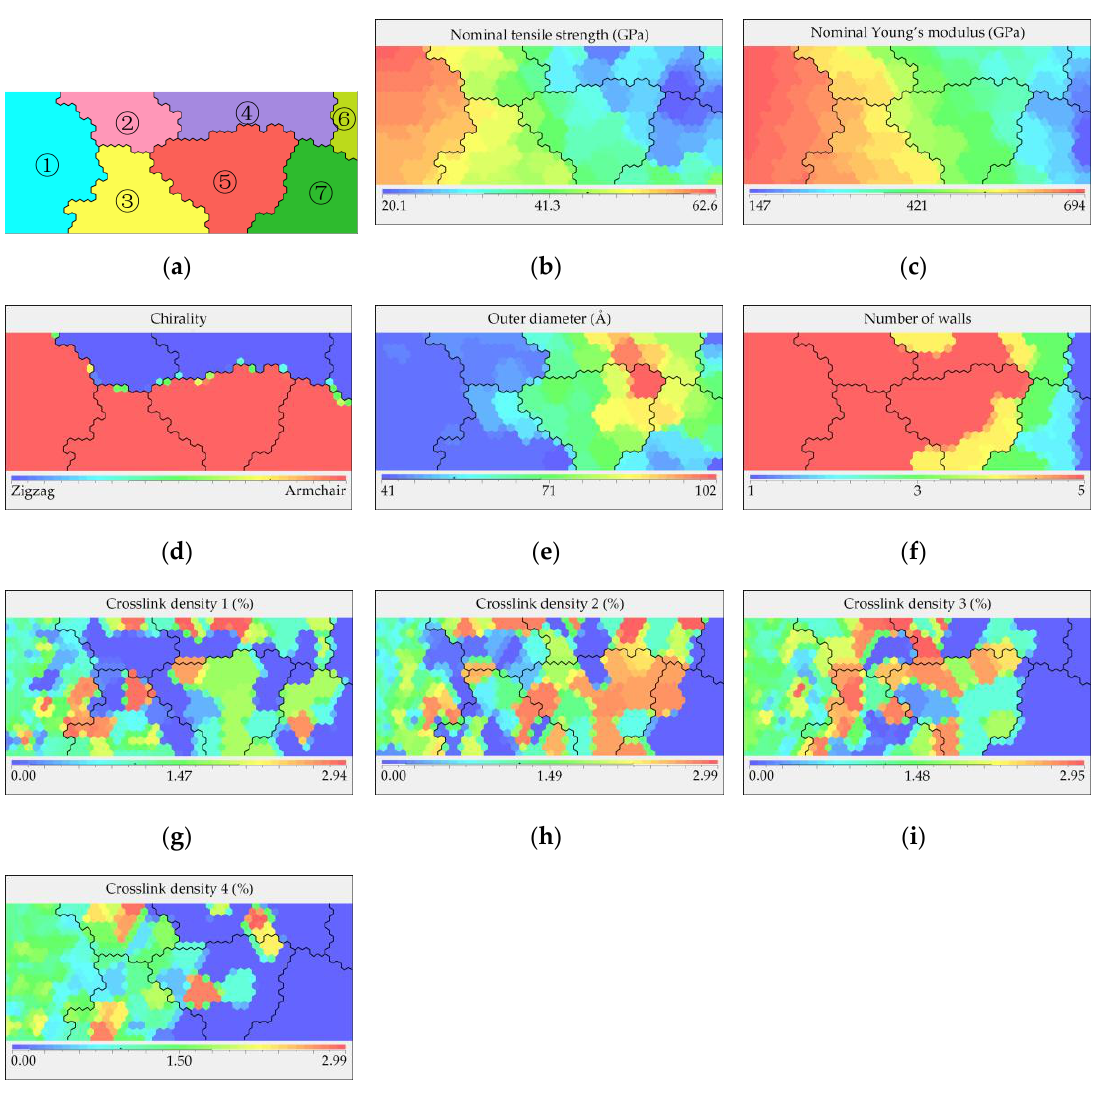
Figure 5. SOM results including the cluster map and heat map. ( a ) Cluster map with 7 clusters; ( b ) Heat map of nominal tensile strength: values range from 20.1 GPa to 62.6 GPa; ( c ) Heat map of nominal Young’s modulus: values range from 147 GPa to 694 GPa; ( d – f ) Heat map of chirality, diameter, and number of walls, respectively; ( g – j ) Heat maps of crosslink density 1–4, where crosslink density 1 is the density corresponding to the innermost wall, and crosslink density 4 is the density corresponding to the outermost wall.